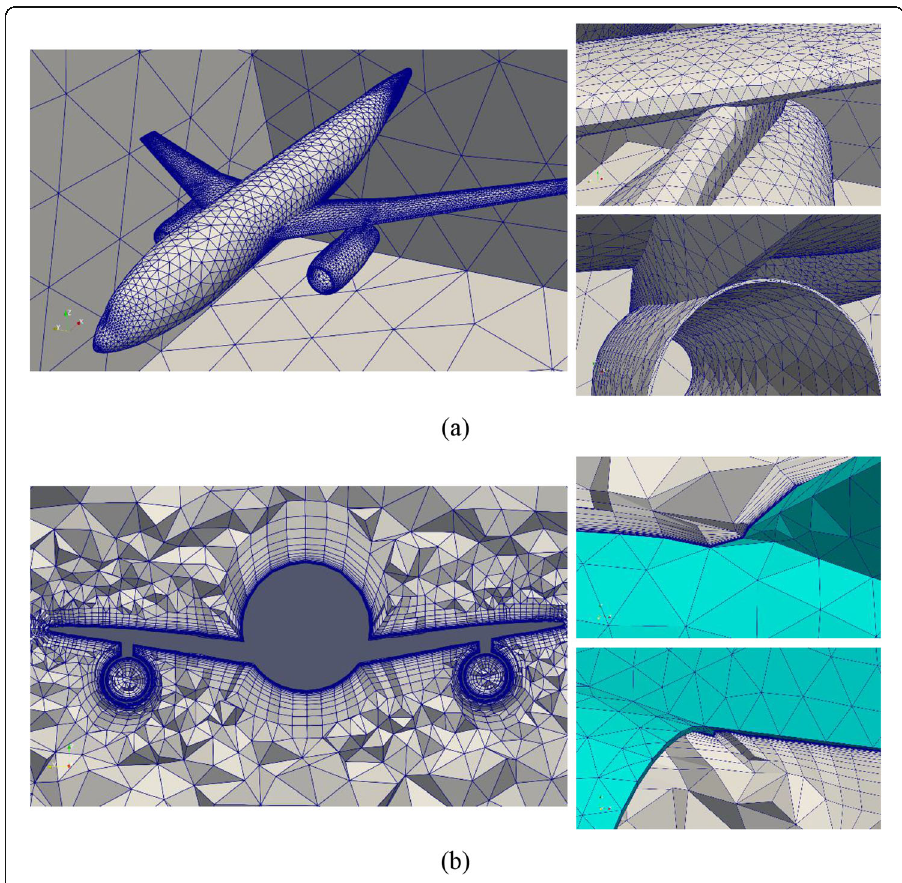
Fig. 6 The hybrid mesh of the F6 model: ( a ) The surface mesh; ( b ) Cut-out views of the hybrid